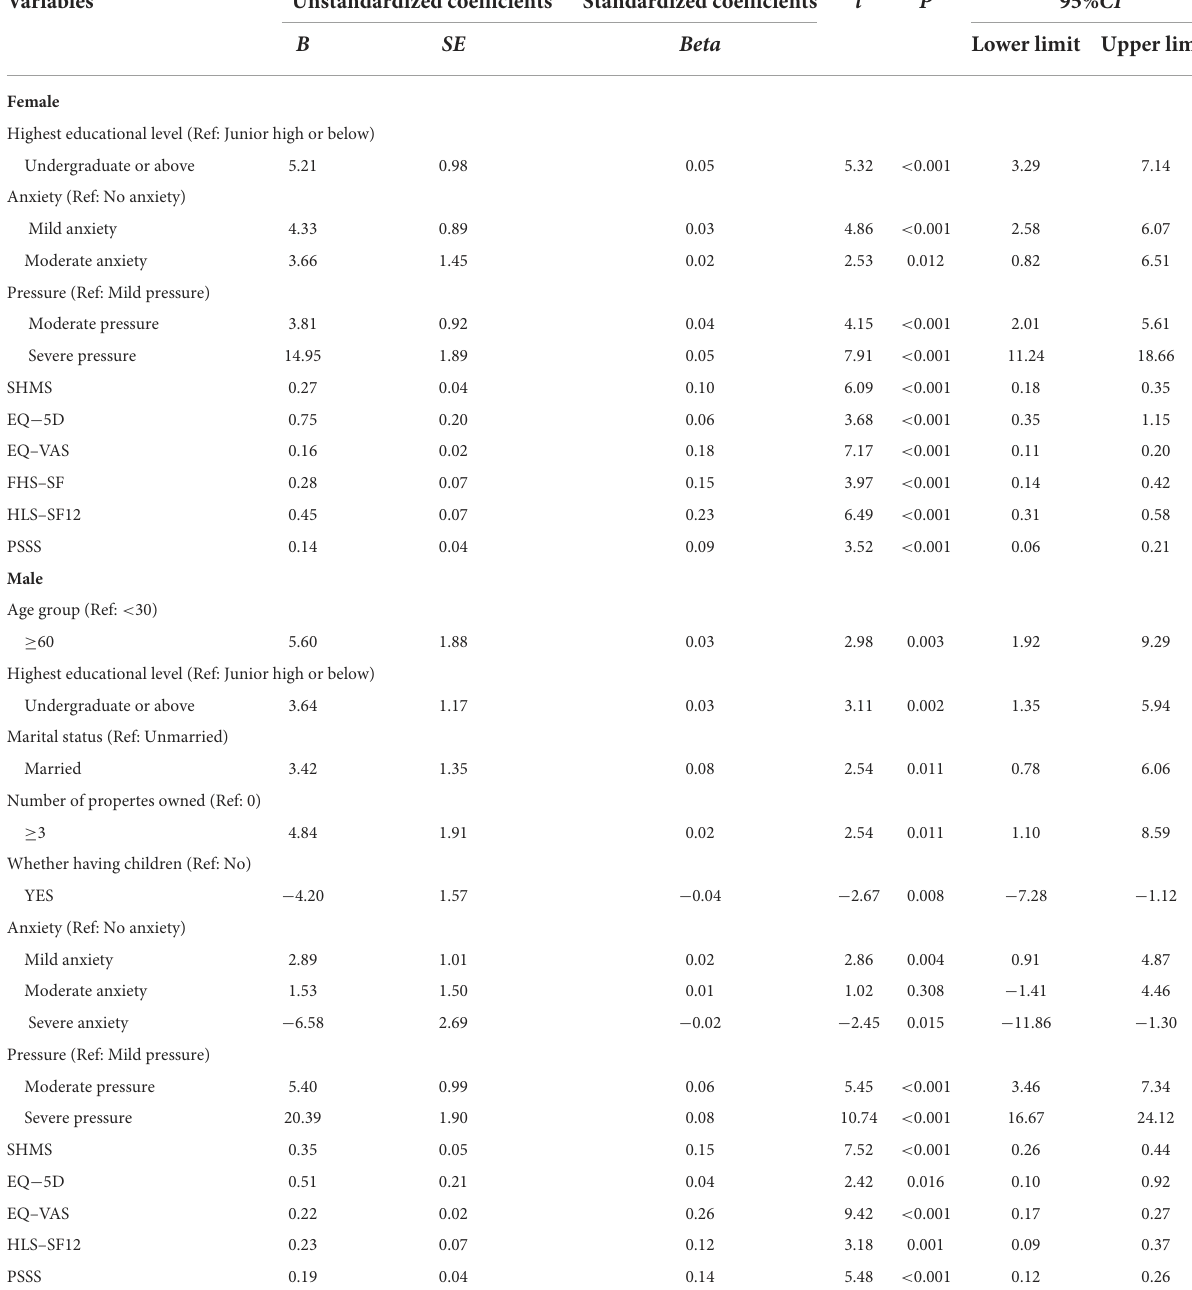
TABLE 3 Hierarchical stepwise regression analysis of predictors of hospice acceptance by gender.